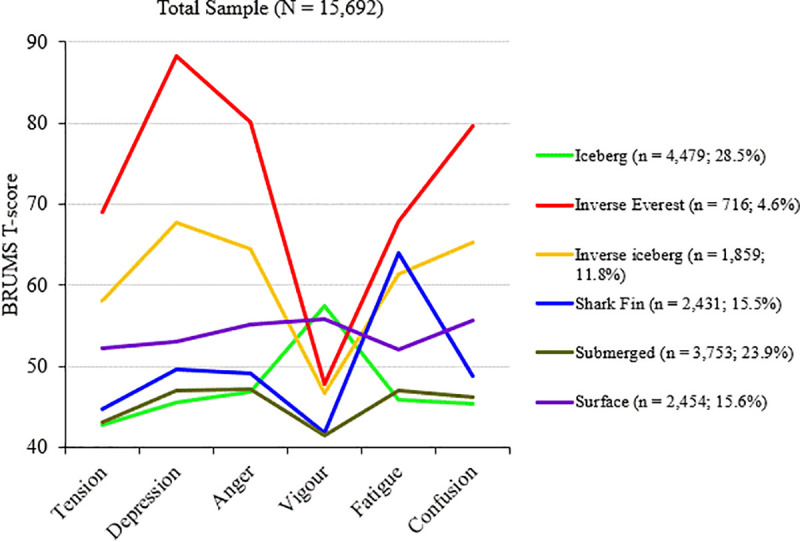
Graphical representation of the six mood clusters.